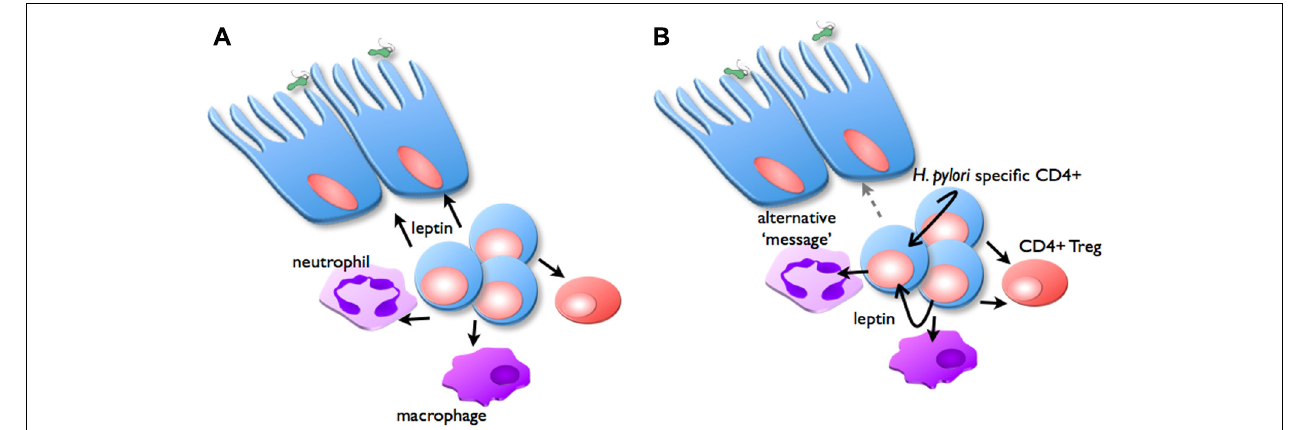
epithelial cells to facilitate protective responses. (B) Alternatively, CD4 + T cells secrete leptin, which acts in an autocrine manner to stimulate their own proliferation, and suppressT reg function. Leptin also affects macrophages and neutrophil function, depending on expression of specific LepR isoforms.This signaling induces secretion of other messages (gray arrow), which in turn stimulate